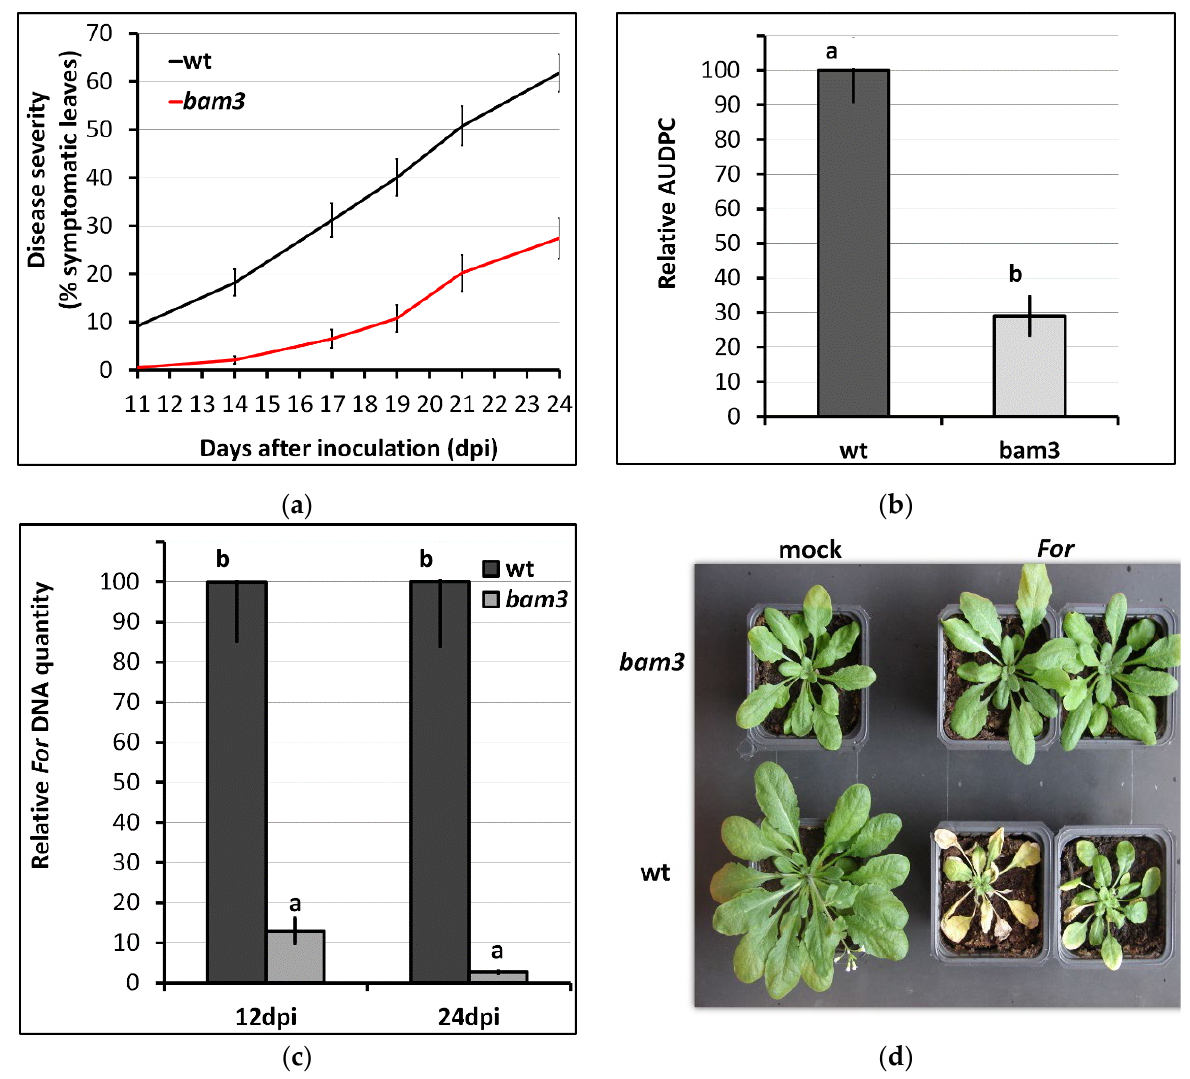
Figure 1. Disease severity in Arabidopsis thaliana bam3 mutants and wt plants inoculated with Fusarium oxysporum f. sp. raphani ( For ), ( a ) periodically recorded for 24 days post inoculation (dpi) and expressed as the percentage of wilting leaves out of the total number of leaves present on each plant in 3 independent bioassays (total of 90 plants); ( b ) expressed as a percentage of the maximum possible area under the disease-progress curve for the whole period of the experiment, referred to as relative AUDPC; ( c ) relative quantification of For DNA in wt and bam3 plants. The fungal DNA levels were estimated by qPCR of the total DNA, isolated from the aerial parts of 10 plants constituting one biological replicate per genotype and treatment, sampled at 12 and 24 dpi. The columns represent the means of three independent bioassays, with each bioassay consisting of 30 plants per genotype and treatment. The vertical bars indicate standard errors, and columns with different letters are statistically different according to Fisher’s LSD multiple-range test at p ≤ 0.05; ( d ) Fusarium-wilt symptoms caused on For -inoculated or mock A. thaliana bam3 and wt plants at 21 dpi. Mock bam3 plants showed induced expressions of AMY3 , ISA3, and DPE1 compared to wt mock plants at three dpi (3.6-, 12.4-, and 7.5-fold, respectively) (Figure 2). The above genes were also induced 2.4-, 9.2-, and 12.2-fold, respectively, in inoculated mutant plants compared to the noninoculated ones. At seven dpi, no differential gene expression was observed with the exception of ISA3 , which was induced 9.6-fold in For -inoculated bam3 plants compared to the mock mutant plants (Figure